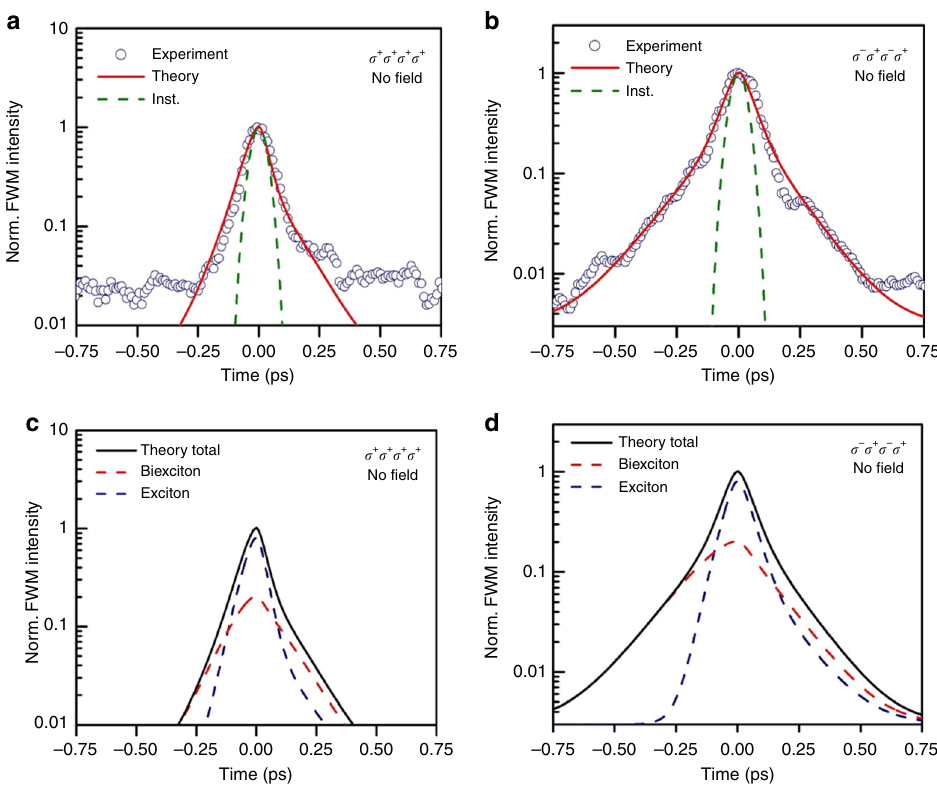
Fig. 3 Time-integrated FWM using circular polarizations. Time-integrated FWM intensity as a function of the time delay τ at zero magnetic fi elds for two different polarization sequences ( σ + σ + σ + σ + ) ( a ) and ( σ − σ + σ − σ + ) ( b ), where the individual polarizations correspond to the laser pulses A * , B, C, and detection, respectively. The time delay T between pulses B and C is kept fi xed at 0 fs. Blue circles are the experimental data, whereas the red lines are the time-integrated FWM calculated using time-dependent DFT. The dashed green lines correspond to the instrumental response. The background noise level is lower for ( σ − σ + σ − σ + ) polarizations, due to better rejection of scattered light originating from the excitation laser pulses. c , d The fi nal calculated time- integrated FWM curves (black line) are plotted together with contributions arising solely from the two-particle exciton correlations (blue dashed line) and four-particle biexciton correlations (red dashed line) for the two polarization